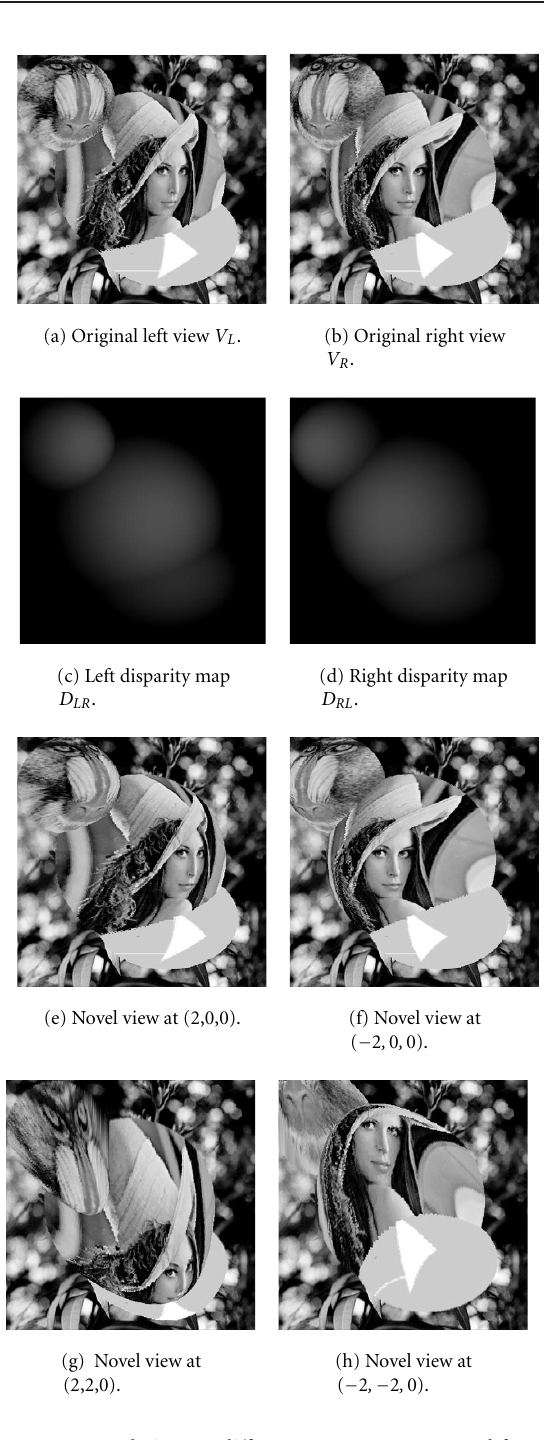
(2) Dynamic viewpoint . The view point C D moves along a circle with the diameter coincident with the baseline b